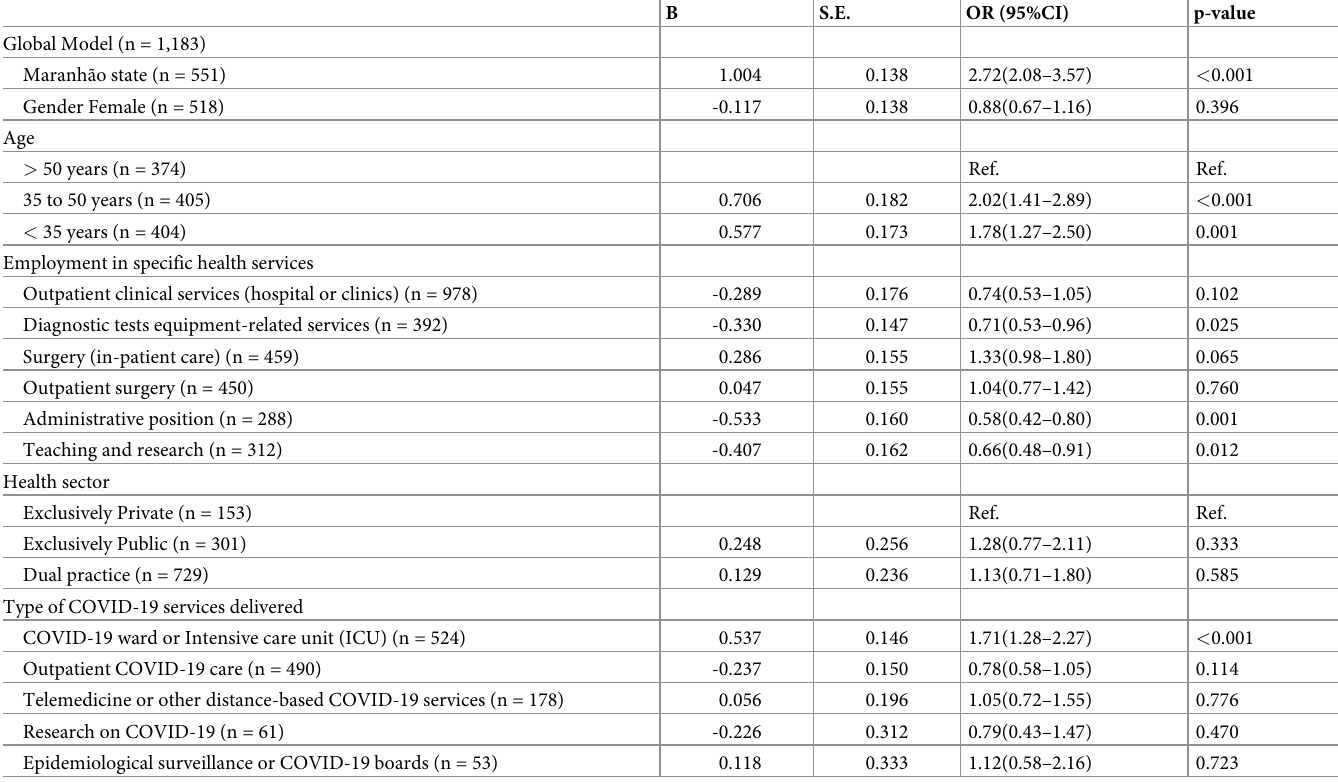
Table 3. Multivariate regression model for physicians personal and professional characteristics and probability of being infected with SARS-CoV-2